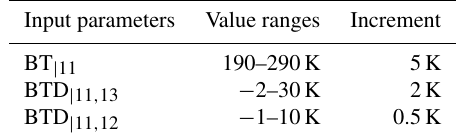
Table 2. Parameter ranges and discretization of parameters in the LUTs for e c (Fig. 4) and (cid:49)e c (Fig. 5). Input parameters Value ranges Increment BT | 11 190–290K 5K BTD | 11 , 13 − 2–30K 2K BTD | 11 , 12 − 1–10K